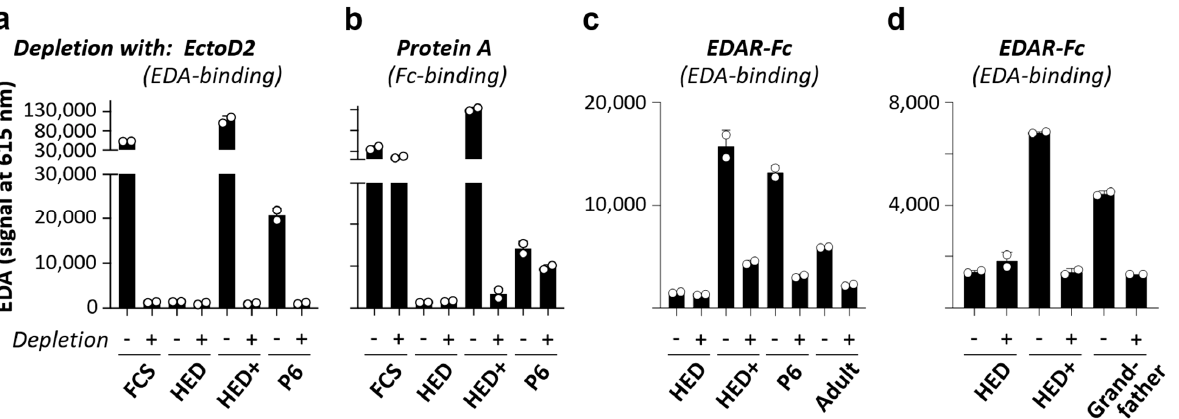
Figure 5. Circulating EDA, as determined by AlphaLisa, following pre-depletion with EctoD2, protein A, or EDAR-Fc. ( a ) Fetal calf serum (FCS), serum from an adult subject with XLHED, either pure (HED) or spiked with Fc-EDA (50 ng/mL; HED+), and serum from subject P6 were depleted twice with EctoD2 (anti-EDA)-coupled beads (+) or TACI-Fc-coupled beads (-). EDA in flow-through fractions was measured by AlphaLisa. ( b ) Same as ( a ) except that serum was depleted four times with Protein A-coupled beads (+) or Sepharose 6B beads (-). The beads were then acid-eluted and released immunoglobulins were quantified. No immunoglobulin was detected in the 4th elution of Protein A, indicating successful target depletion. There was no retention of immunoglobulins on Sepharose 6B. ( c , d ) Same as ( a ) except that sera were depleted once with EDAR-Fc (+) or with TACI-Fc (-) and that serum from an adult subject with XLHED was spiked with Fc-EDA at a concentration of 5 ng/mL (HED+). Measurements were conducted in duplicates. Adult, healthy adult control.